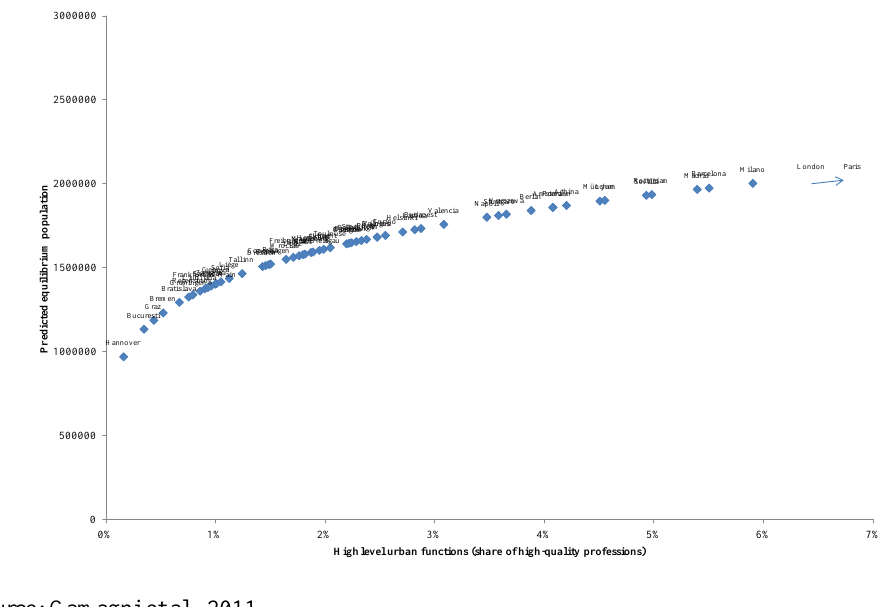
Figure 4: Equilibrium City Size for Different Levels of High Order